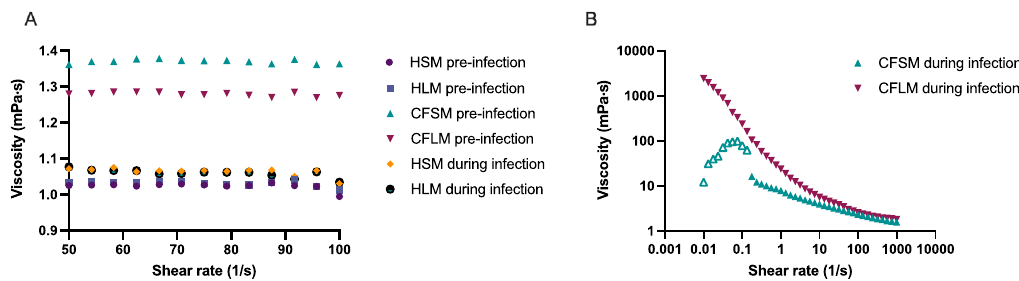
infection and HSM and HLM media during infection). Data points with open triangle in CFSM during infection displayed high level of uncertainty due to non-Newtonian responses and therefore values below 0.1 (1/s) should be treated with caution. Graphs are showing single viscosity measurement per media under each condition.